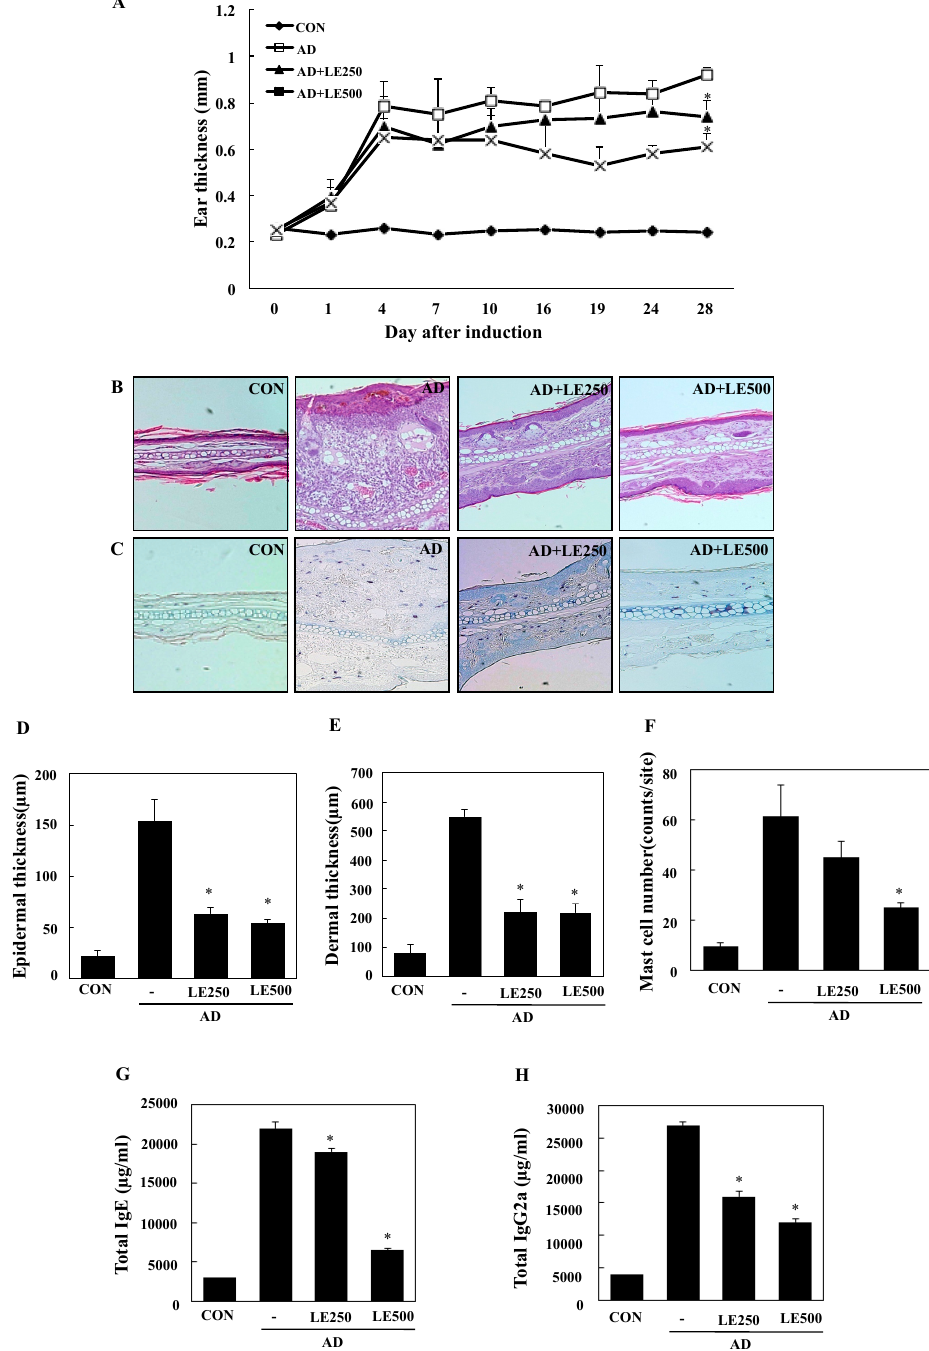
Figure 3. Histopathological and serum analysis to assess the effects of L. edodes extract on ear thickness and mast cell infiltration. Ear thickness was measured with a dial thickness gauge every 3 days after 2,4-dinitrochlorobenzene (DNCB) or Dermatophagoides farinae extract (DFE) application ( A ); Representative photomicrographs of ear sections stained with hematoxylin and eosin ( B ) or toluidine blue ( C ); epidermal ( D ) and dermal ( E ) thickness was measured using microphotographs of hematoxylin and eosin stained tissue; ( F ) The number of infiltrated mast cells was determined on the basis of toluidine blue staining. Blood samples were collected by orbital puncture at day 28. Plasma IgE ( G ) and IgG2a ( H ) levels were quantified by enzyme-linked immunosorbent assay. Data are presented as the mean ± SD of triplicate determinations. * Significant difference from the value of the DFE/DNCB-treated mice at p < 0.05. AD, atopic dermatitis induced by DFE and DNCB treatment. The pictures shown are representative of each group ( n = 3–6). The original magnification was 100×. CON, control; L. edodes , Lentinula edodes ; AD, atopic dermatitis.